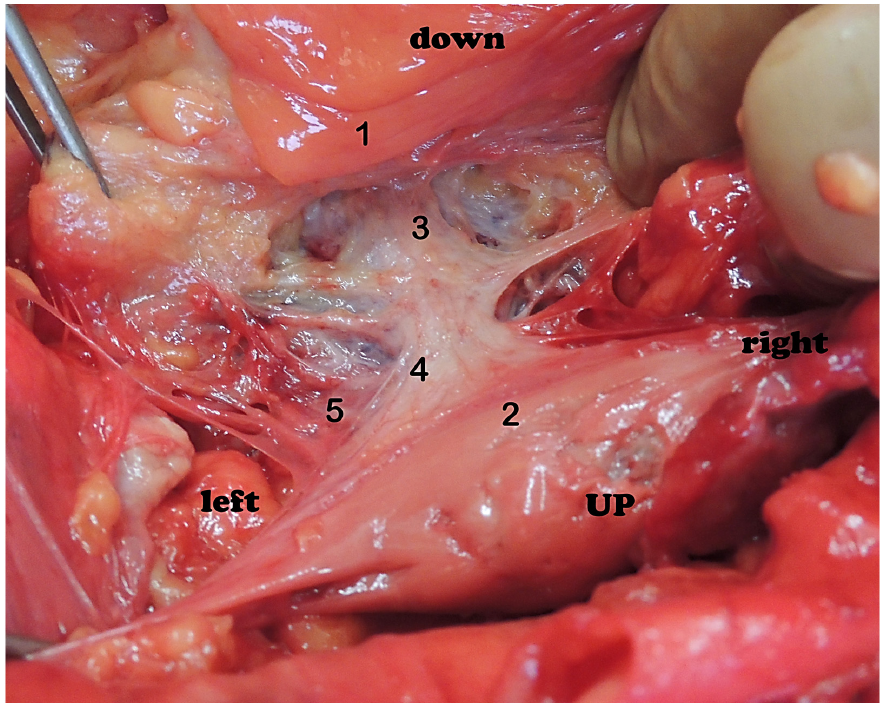
Figure 9. Uterovaginal plexus, front view, craniocaudal direction. Asymmetric formation of the uterovaginal plexus (5), uterus (2), vagina (3), small ganglia on the anterior and lateral sides of the vagina (4), bladder (1).